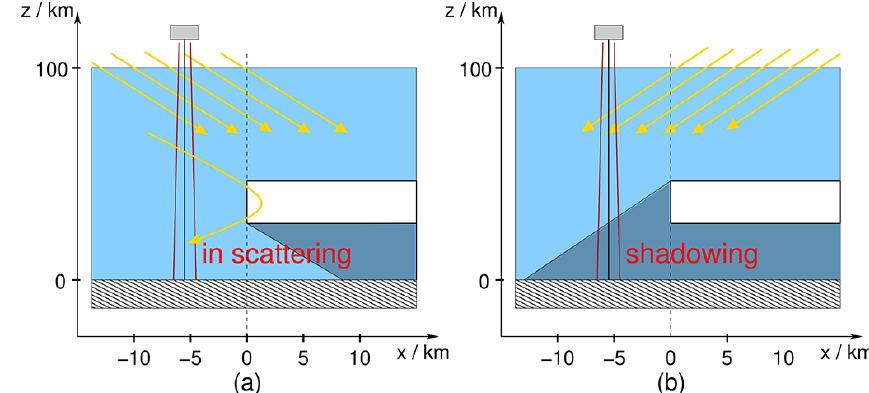
Figure 2. Schematic of 2D box-cloud scenario: panel (a) shows the in-scattering geometry and (b) the shadowing